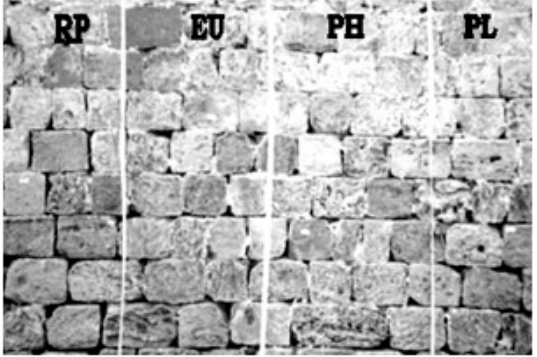
Figure 14. Consolidated masonry under investigation.